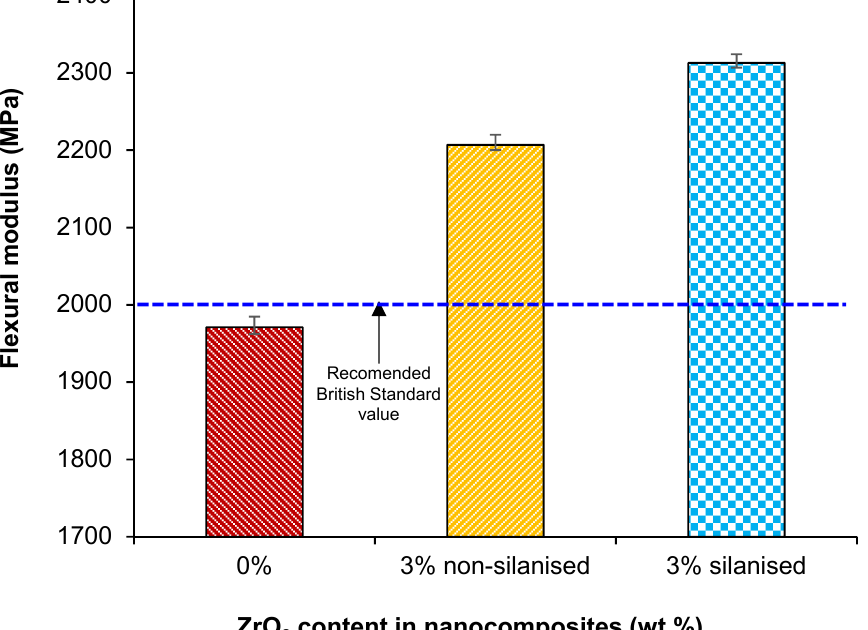
Figure 6. Bar chart showing the effect of treating zirconia nanoparticles on the flexural modulus of the PMMA-zirconia nanocomposites.